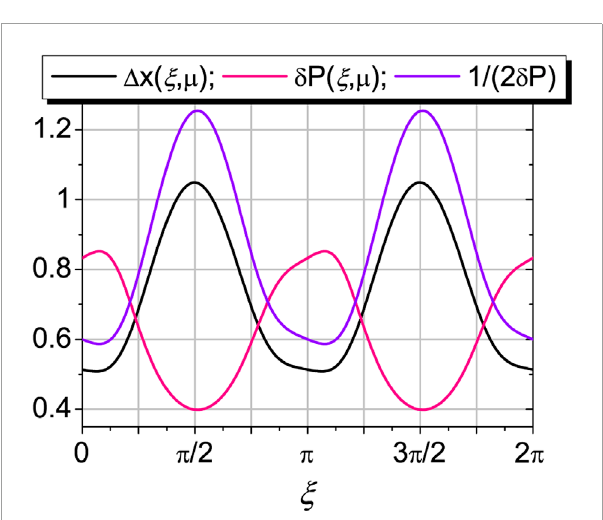
FIGURE 4 Dependence of the lower limit deviations Δ x ( ξ , μ ) and δ P ( ξ , μ ) on the state labeled by ξ at μ = 0 . 18. The running deviations Δ x and Δ P satisfy the GUP Δ x Δ P ≥ Λ/ 2 and vary in the ranges Δ x ( ξ , μ ) ≤ Δ x ≤ R ( μ = 0 . 18 ) ≃ 2 . 89 and δ P ( ξ , μ ) ≤ Δ P ≤ 1.